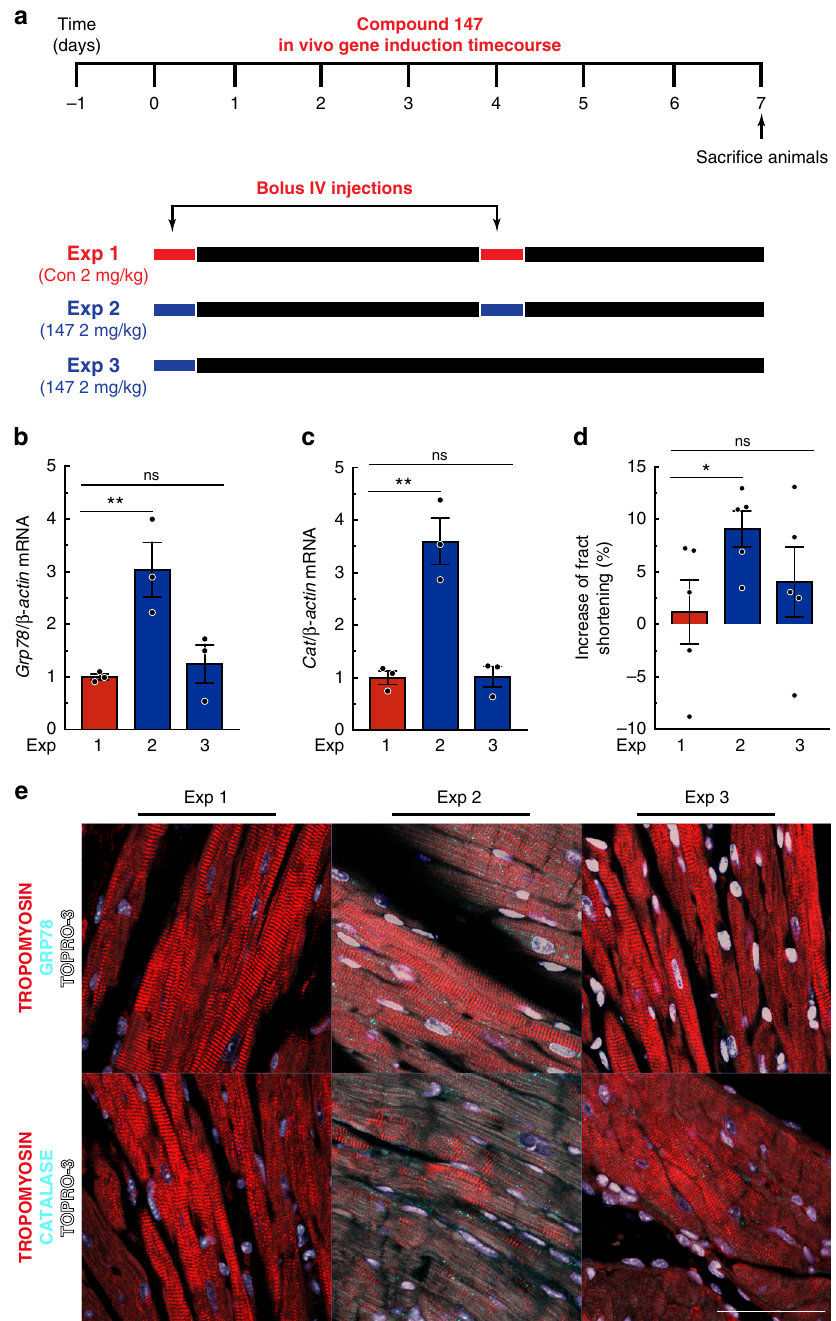
Fig. 6 147 gene induction timecourse in vivo. a Experimental design testing the effects of 147 in WT untreated mice. Red bars depict the bolus administration of the control compound, while blue bars depict the bolus administration of 147 . b , c qPCR for Grp78 ( b ) or Cat ( c ) in LV of mice from indicated experiments ( n = 3). d Percent increase in fractional shortening. Detailed analyses of echocardiography parameters are in Extended Data Table 2 ( n = 5). e IHC staining of GRP78 or CAT (cyan), tropomyosin (red), and nuclei (TOPRO-3, white) in LV of mice from respective experiments. Tissue sections are representative images from one mouse per condition. Scale bar represents 50 µ m. Data are represented as mean ± s.e.m. Two-group comparisons were performed using Student ’ s two-tailed t test, and all multiple group comparisons were performed using a one-way ANOVA with a Newman – Keuls post hoc analysis. * P ≤ 0.05 and ** P ≤ 0.01; ns not signi fi